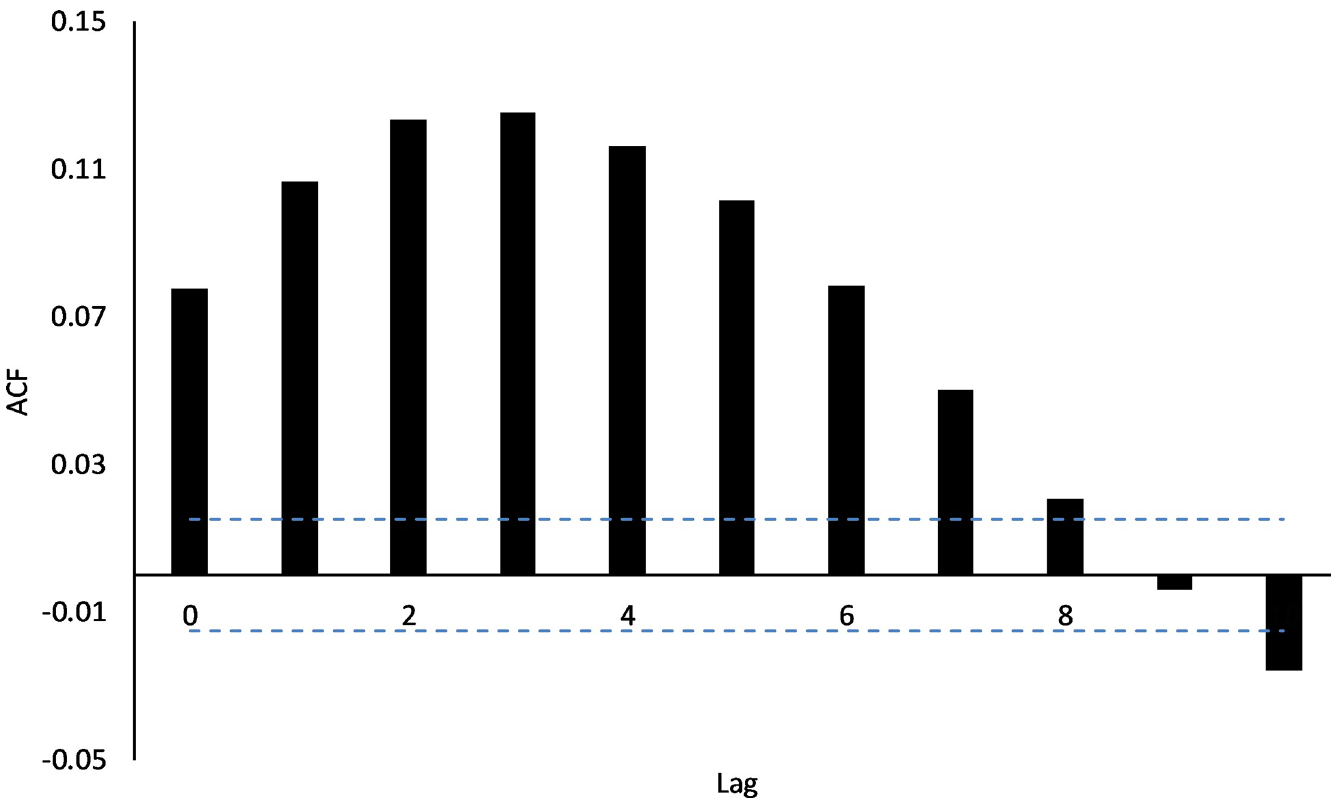
Fig 6. Cross-correlation between tide height and EC measured at the 50m above bund location. Maximum correlation occurs at a lag of 3 which is equivalent to a 3-day delay between tides experienced at the coast and measured changes in EC.